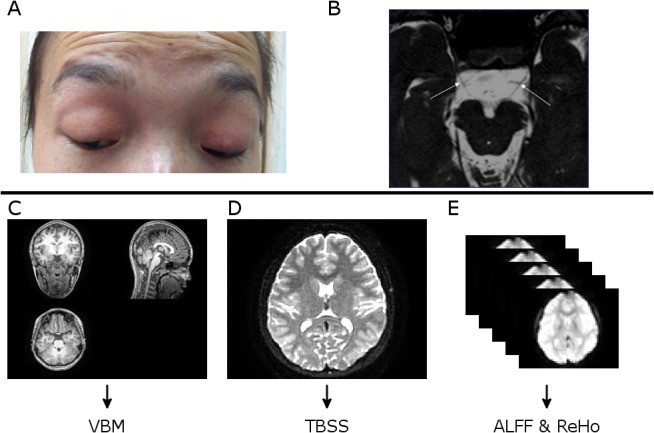
The research strategy and experiment design.A, Phenotypes of a typical patient with CFEOM1; B, CNIII (Oculomotor nerve) hypoplasia shown in MRI (arrows) of this typical patient with CFEOM1 which were used to identify the atrophy of extraocular muscle. The structural abnormality of optic nerve and extraocular muscles have been well studied in CFEOM. We then focus on the cerebral alterations associated with CFEOM; C, T1-weighted MRI scanned from the patient, shown with three different views. T1 data were later feed into VBM processing pipeline; D, The DTI images scanned from the patient. DTI date were then used in TBSS processing; E, The resting—state fMRI data from this CFEOM1 patient. ALFF and ReHo processing were then carried out using the resting-state fMRI data.